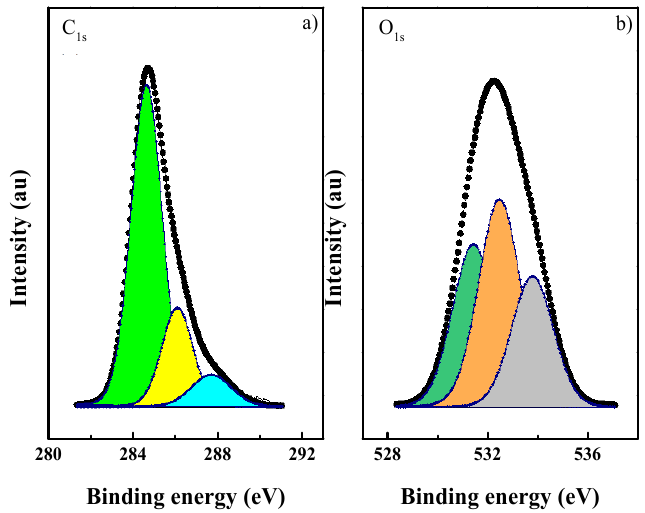
Figure 2. X-ray photoelectron spectra for CN: ( a ) C 1s core level and ( b ) O 1s core level. Circles are experimental data and solid lines are fits to the data. The functions in which the spectra are split are also shown as curved filled with di ff erent colours.